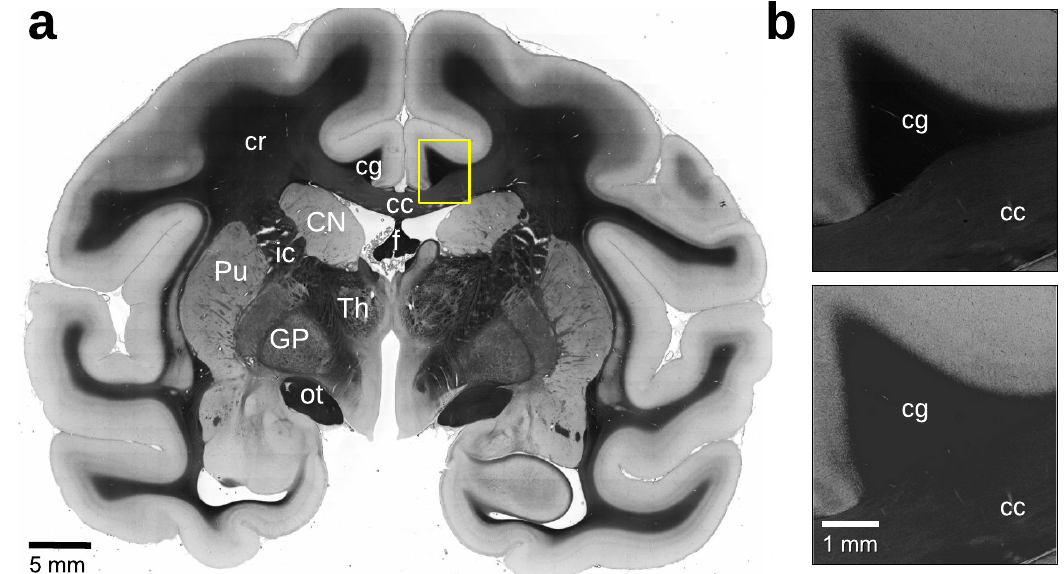
Figure 4. Correction of transmittance values. ( a ) Median-filtered transmittance image of the coronal vervet brain section. Anatomical regions are labelled for better reference (refer to Fig. 3). ( b ) Comparison of transmittance images (yellow rectangle) before (top) and after (bottom) shifting the transmittance values of out- of-plane nerve fibres to T ref